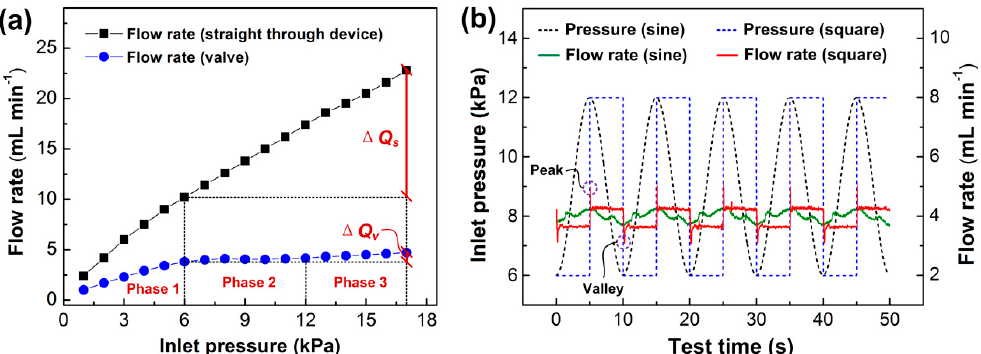
Figure 6. Flow rates of the microfluidic passive valve under varied inlet pressures. ( a ) Valve flow rate under static pressures. ∆ Qs and ∆ Qv represent the increments of flow rates under inlet pressures from 6 kPa to 17 kPa, respectively. ( b ) Valve flow rate under dynamic inlet pressures. The black and blue dash lines represent the sinusoidal pressure and the square pressure, while the green and red solid lines represent the flow rates of the valve under the above two pressures, respectively.